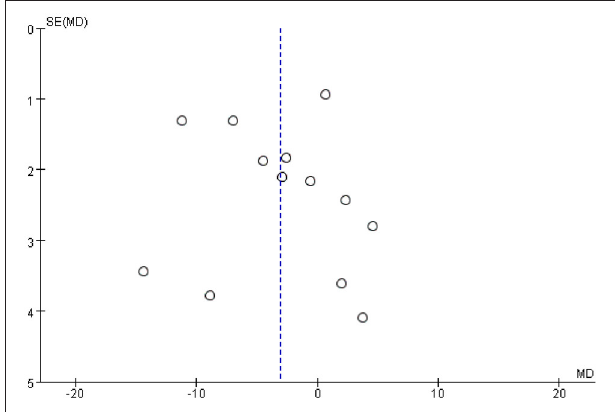
FIGURE 7 | Funnel plot: SD by mean difference and each dot represents 1